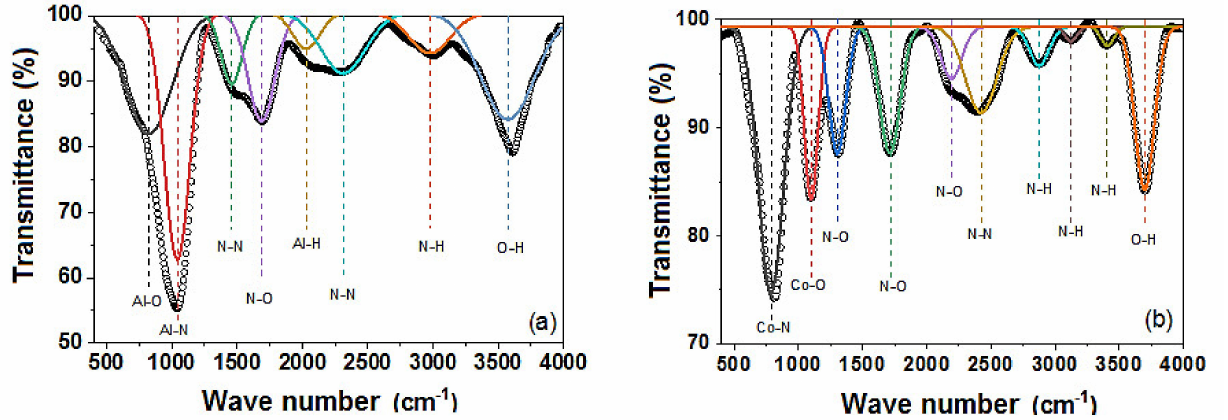
Figure 6. FTIR spectra obtained from the single layer coatings: ( a ) Aluminum nitride (AlN) and ( b ) Cobalt nitride (CoN).